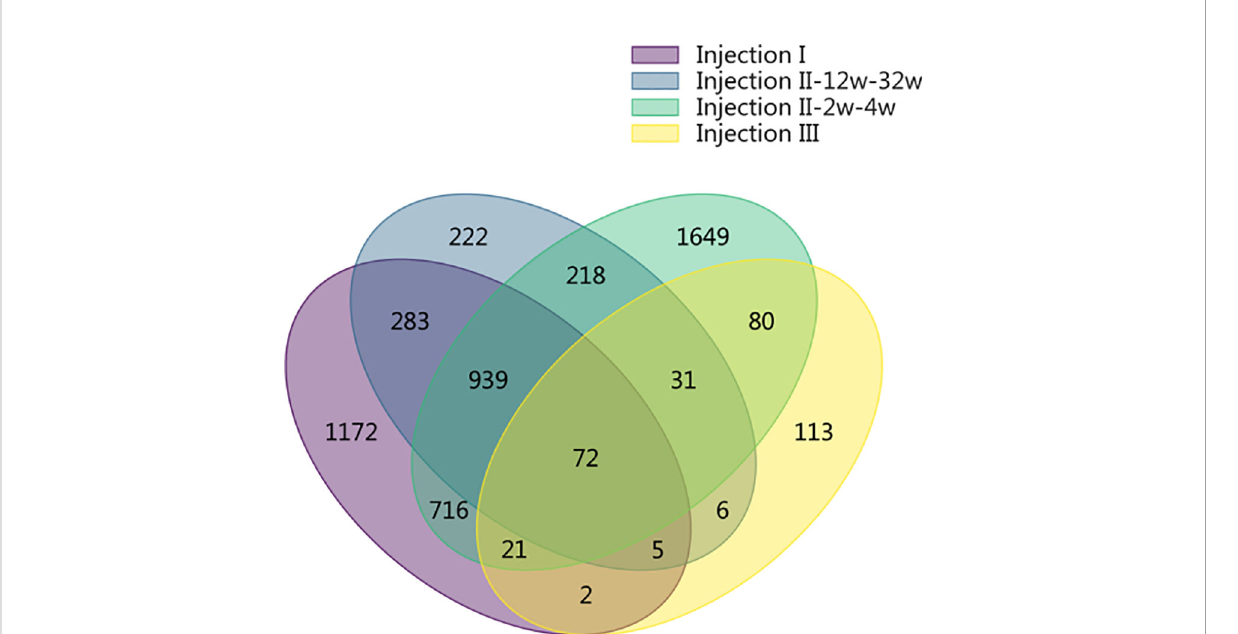
FIGURE 3 Venn diagram showing the SDPs that were unique identi fi ed to each phase of the inoculation protocol. In the post-injection I period and in the post-injection III period, we identi fi ed 1,172 and 113 unique SDPs, respectively. Altogether, there were 2,089 SDPs unique to the post-Injection II period, only 218 of which were found for both the short-term and long-term samples. Of the remaining 1,871 SDPs from this period, 222 were unique to the long-term samples while 1,649 were unique to the short-term samples (FDR = 0.05). Only 72 SDPs were common throughout the entire immunization cycle, indicating that the long- and short-term samples showed different antibody binding